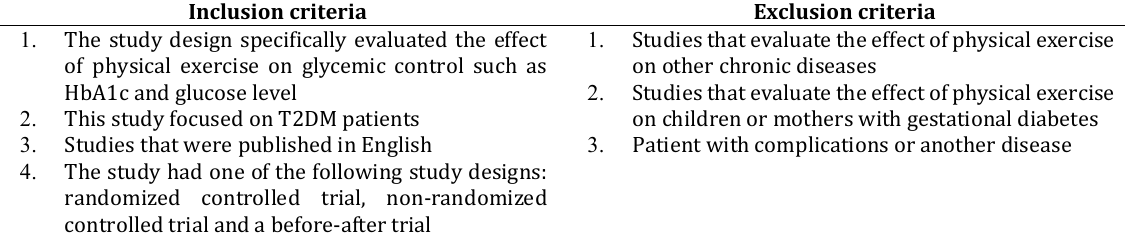
Table 1. Inclusion and exclusion criteria